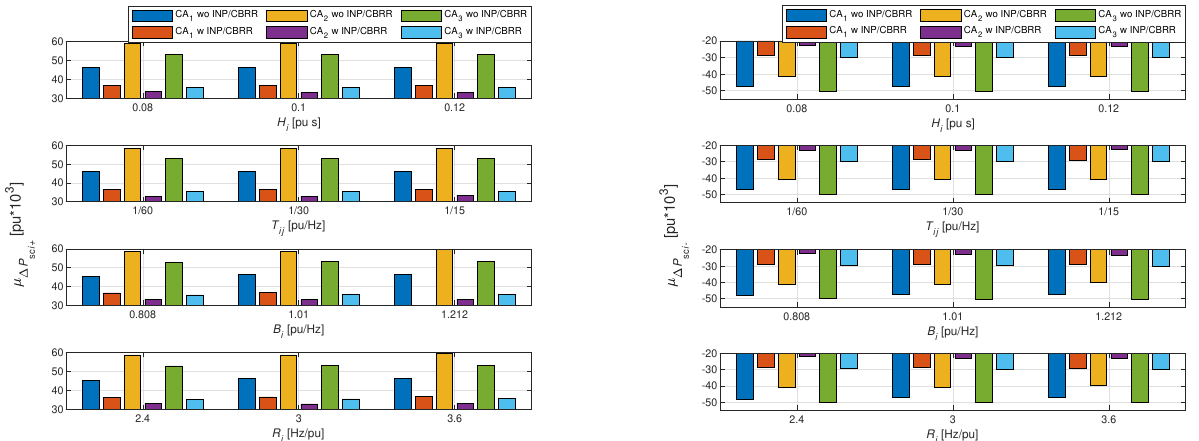
Figure 15. Average values of µ RoCoF where “wo INP/CBRR” is without and “w INP/CBRR” is with the INP and CBRR.